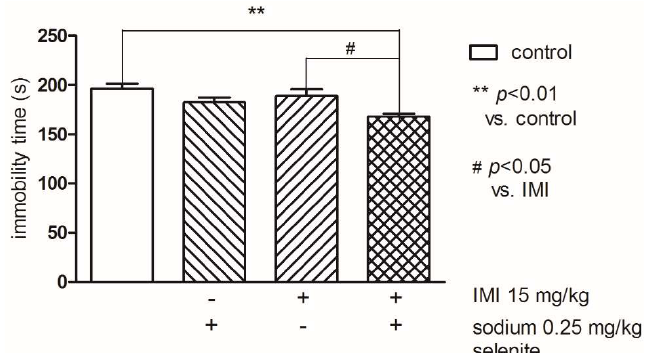
Figure 2. The effects of combined administration of Se and imipramine (IMI) on the immobility time in the FST in mice. The values represent the mean ± SEM. Sodium selenite was injected IP 30 min before the test. ** p < 0.01 vs. control vehicle-treated group, # p < 0.05 vs. IMI (Bonferroni’s test).